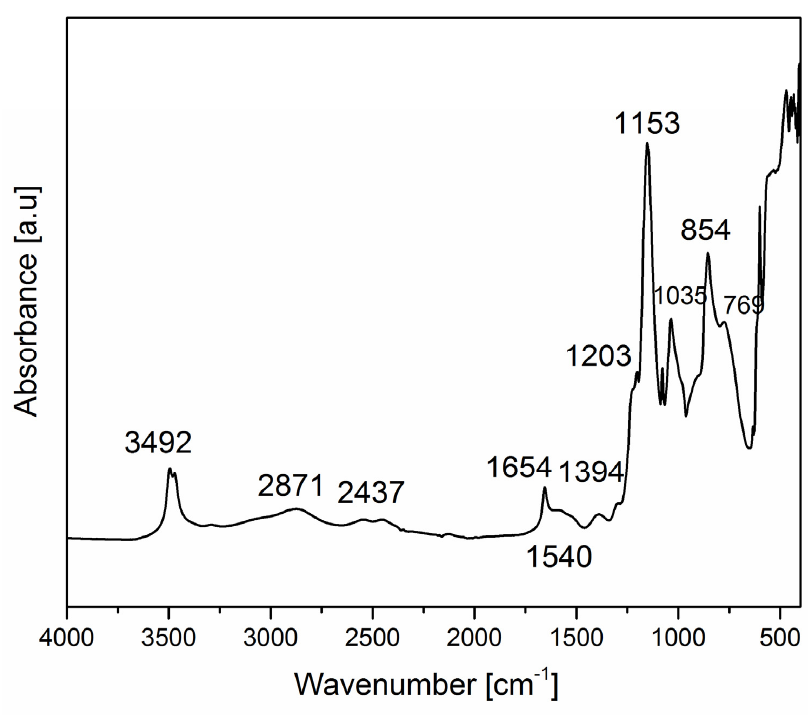
Figure 1. FTIR spectrum of lab-synthesized mPSS.